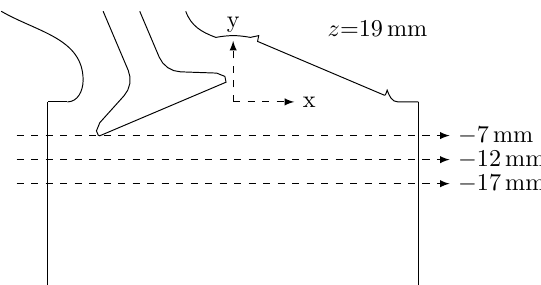
7mm, 12mm and 17mm in the mid valve − − −